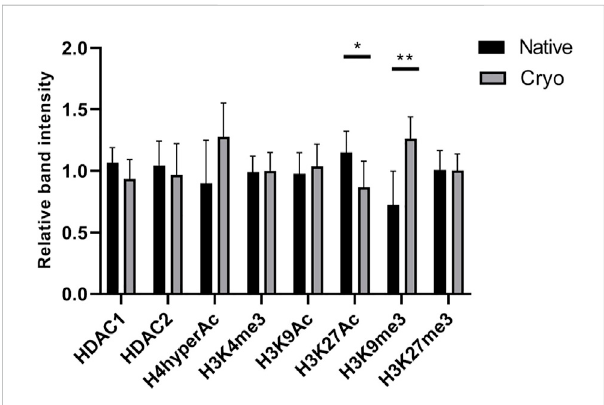
Assessment of protein levels in native and cryo stromal cells. Proteins associated with epigenetic regulation were evaluated using Western blot analysis, and relative band intensity was calculated with ImageJsoftware.ThelevelsofHDAC1and HDAC2 proteins were normalized to GAPDH and histone modi fi cations according to H3 and H4 loading controls. Results are presented as mean ± S.D. ( n =